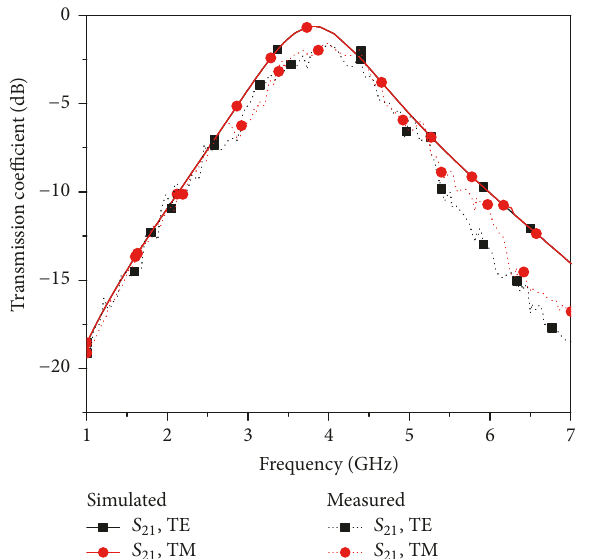
Figure 5: Simulated and measured transmission coefficient under normal